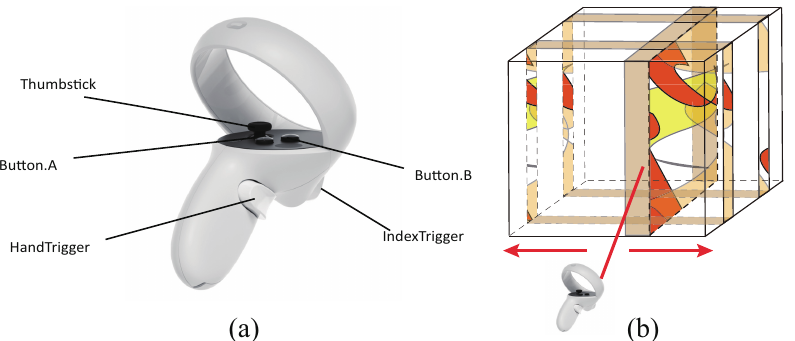
Figure 2. Buttons and joystick on the Touch Handle can be defined to map to different functions. ( a ) The joystick “Thumbstick" is connected to the rotation interaction in our experiment and user study. Buttons “A" and “B" can be used to perform the zoom in and zoom out of the rendering result. ( b ) Users control the position of the slice of armchair stratigraphic mode and the slice of palisade stratigraphic mode in real-time through the handle and the buttons.